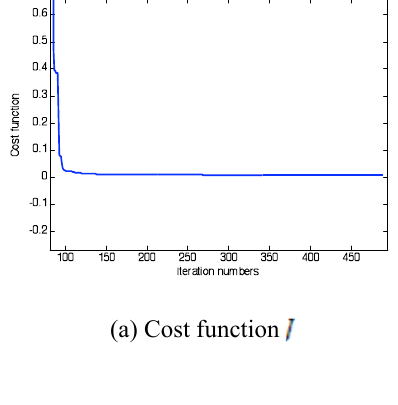
Controllers switching strategy